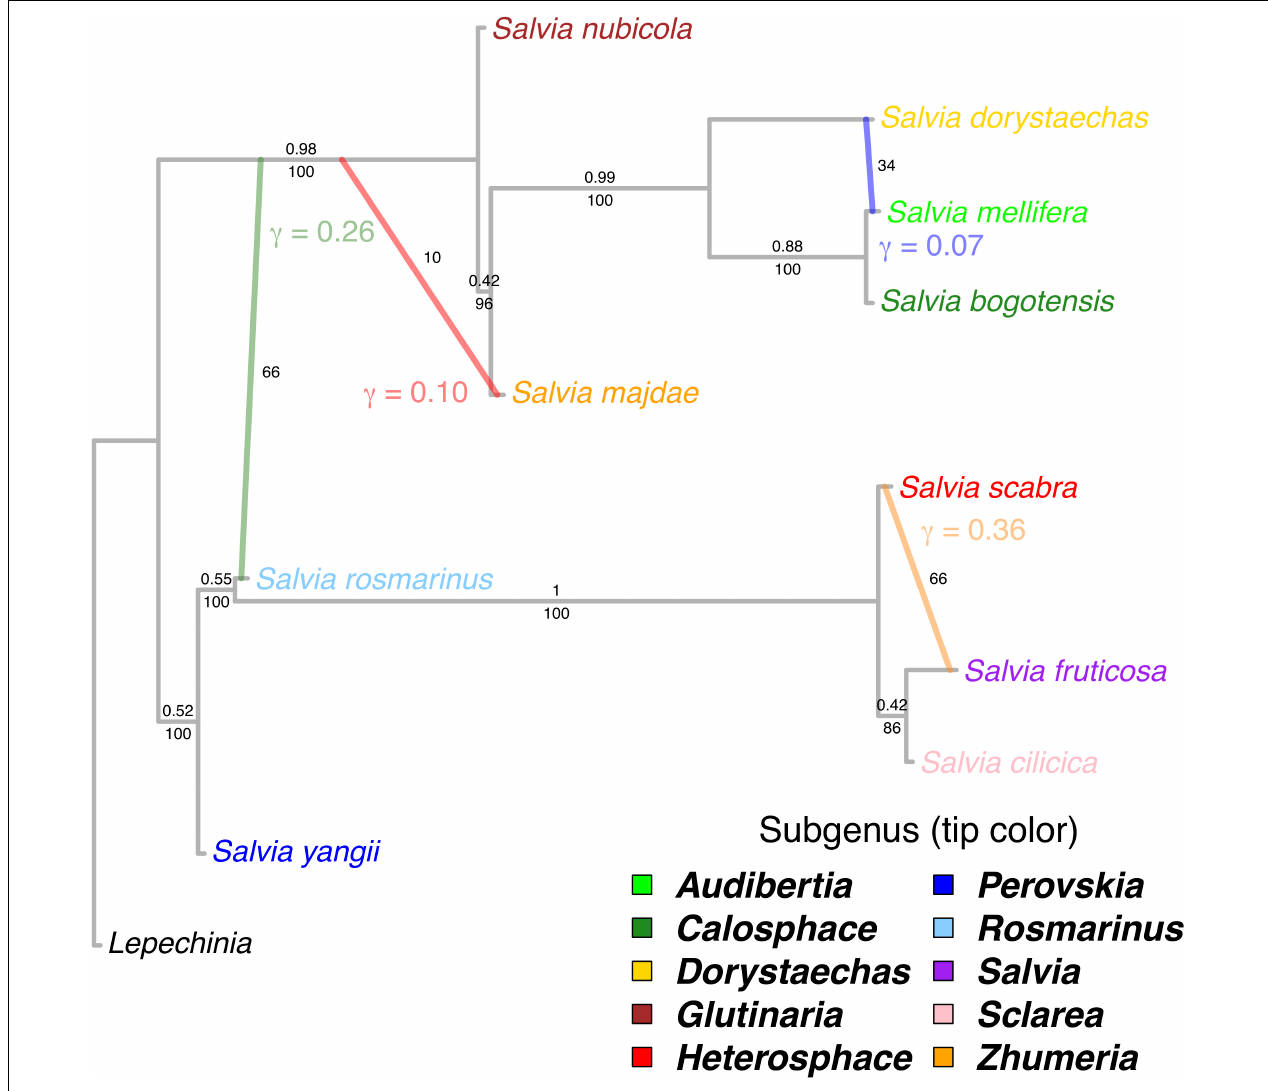
FIGURE 3 | Phylogenetic network based on 57 nuclear genes depicting backbone relationships in Salvia with one exemplar per subgenus, with internal branch lengths in coalescent units. The best-fitting network has four reticulation events. Inheritance probabilities ( γ ) are indicated next to the lineage which is inferred to have received genetic material. The numbers above the branches on the bifurcating major topology are quartet concordance factors or the proportion of the genome supporting each quartet. The numbers below the major topology branches and to the right of hybrid branches are bootstrap support values. Ingroup tips are colored by